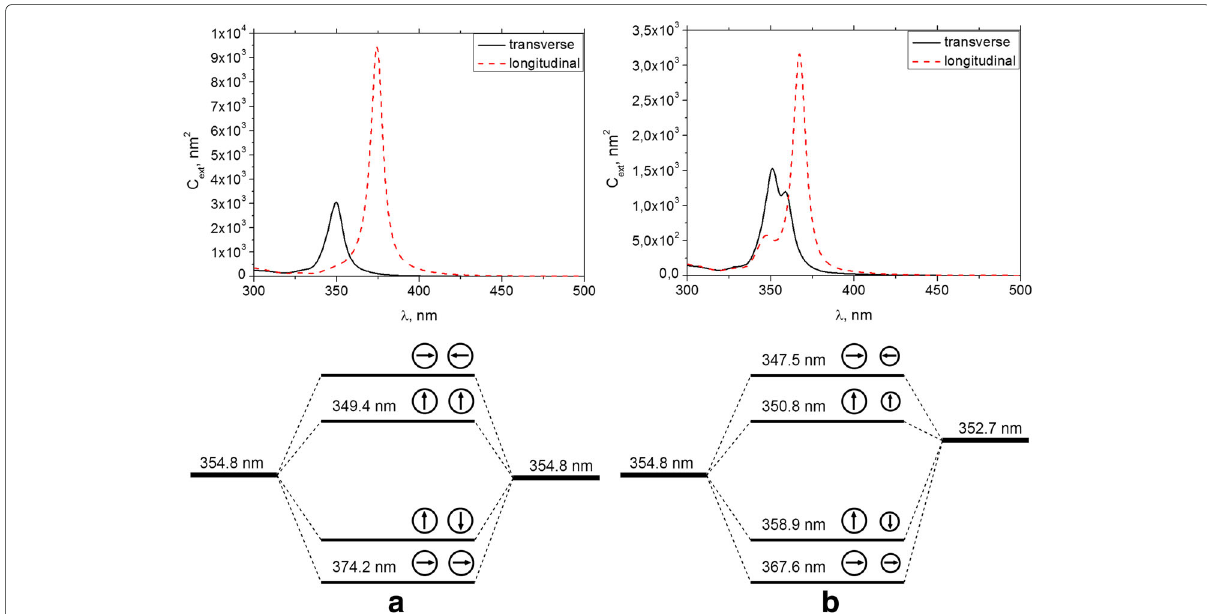
Fig.2 The extinction spectra of the dimer under the transverse and longitudinal incident field polarization and the plasmon hybridization schema for a dimer with the same nanoparticle size r = 10 nm (homodimer), b dimer with different nanoparticle sizes: r 1 = 10 nm and r 2 = 4 nm (heterodimer)